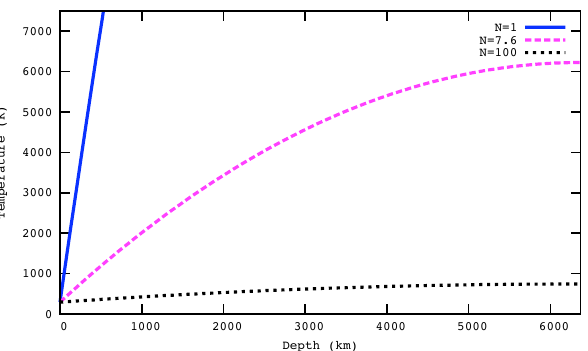
Fig. 6. MEP mantle convection temperature structure with three different Nusselt number values. Depth beneath the surface of the Earth is shown on the horizontal axis. Temperature in degrees Kelvin is shown on the vertical axis. With no mantle convection ( N =1 solid line) the core temperature is > 40000 ◦ K. With high rates of mantle convection ( N =100, dotted line) the core tempera- ture is < 1000 ◦ K. When N is set to the MEP value of 7.6 (dashed centre line) the core temperature is ≈ 6000 ◦